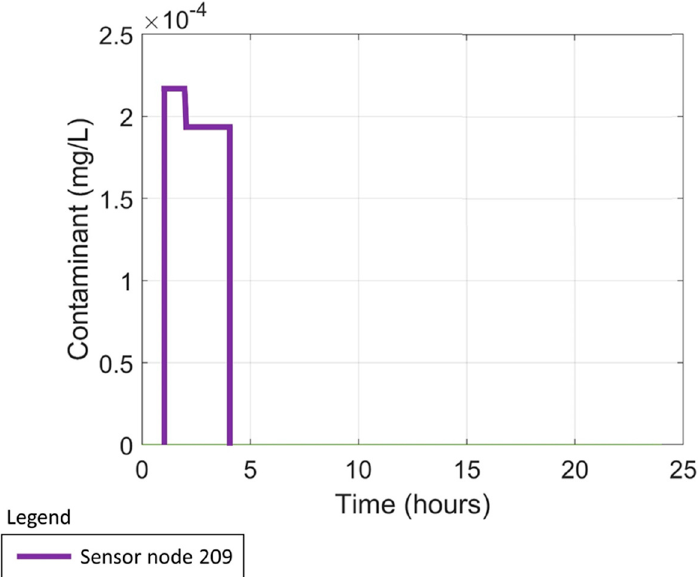
Figure 6. Contaminant concentration measured by the placed mobile sensor equipment over the course of the 24 h simulation. Except for the sensor at node 209, no contaminant concentration was measured. All other measurements from mobile equipment did not detect any contaminations or anomalies in the water.